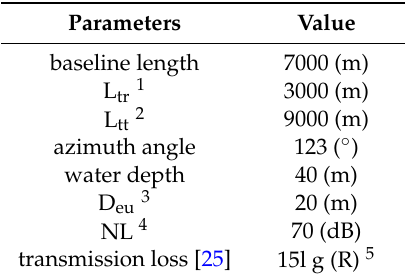
Table 1. Modeling and simulation parameters.